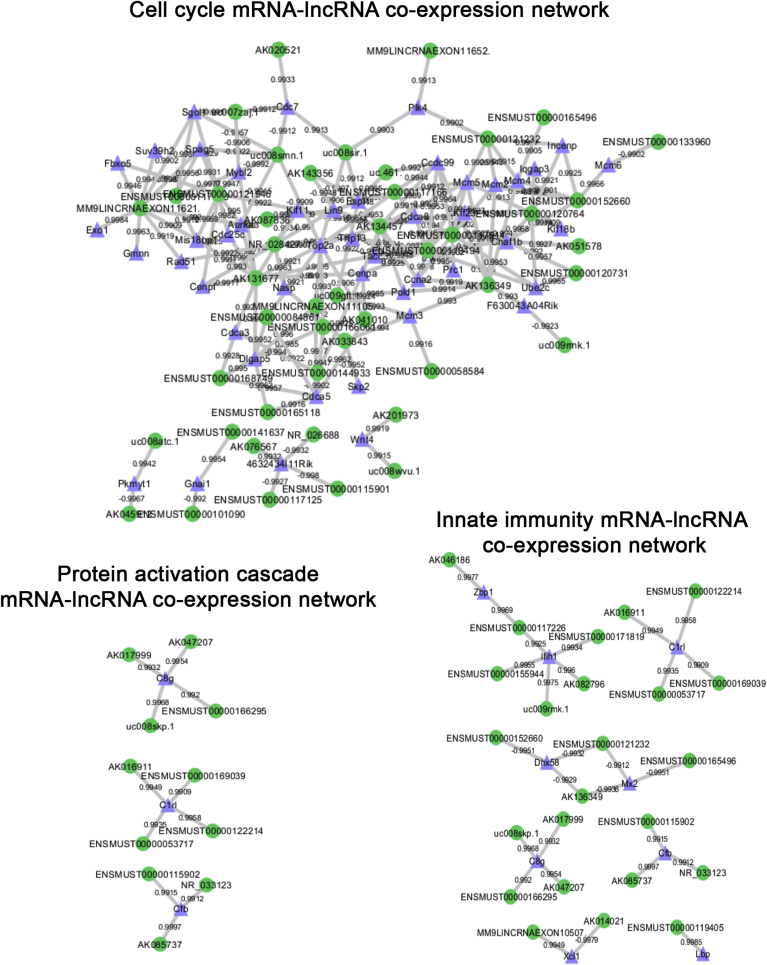
Graphical view of differentially expressed coding-noncoding gene coexpression network analysis represents similar patterns of expression and interconnectivity of the most representative Gene Ontology terms (cell cycle, DNA metabolic process, innate immunity, and protein activation cascades). The interaction network was produced in Cytoscape, where nodes correspond to mRNA (triangles in purple) or lncRNA (circles in green), and the edges are the coexpression links.